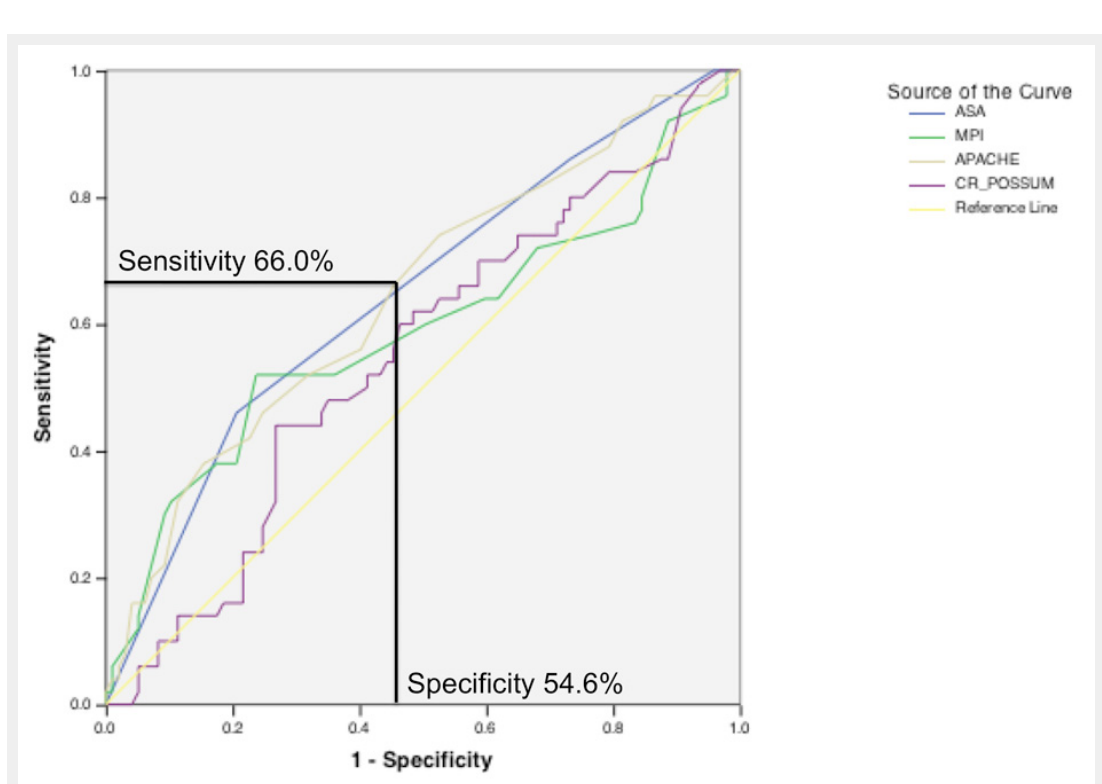
Figure 1 ROC curve. Sensitivity and 1-specificity for the prediction of a relaparotomy are plotted against each other for the different scores evaluated. At a cut-off score of 14 the APACHE II score shows a sensitivity and a specificity of 66.0%, and 54.6%,